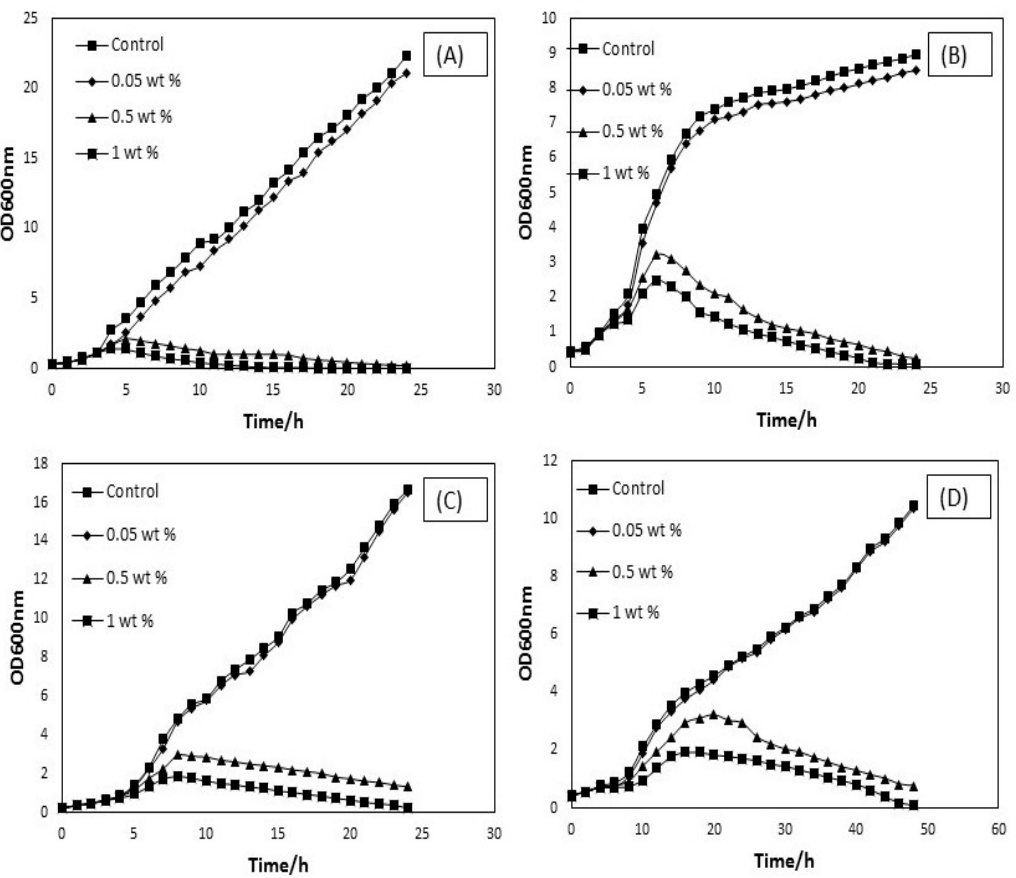
Figure 5. Optical density (OD) growth curves of incubated Staphylococcus aureus ( A ), Pseudomonas aeruginosa ( B ), Klebsiella pneumonia ( C ), and Candida albican ( D ) with different concentration of SDBS.